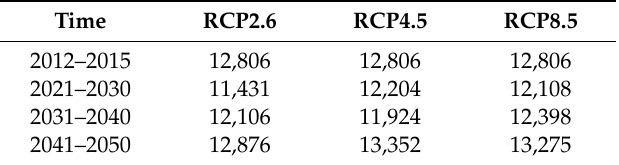
Table 3. Decadal changes of the maize yield in the Gaotai area under the three RCP scenarios (unit: kg/ha). Time RCP2.6